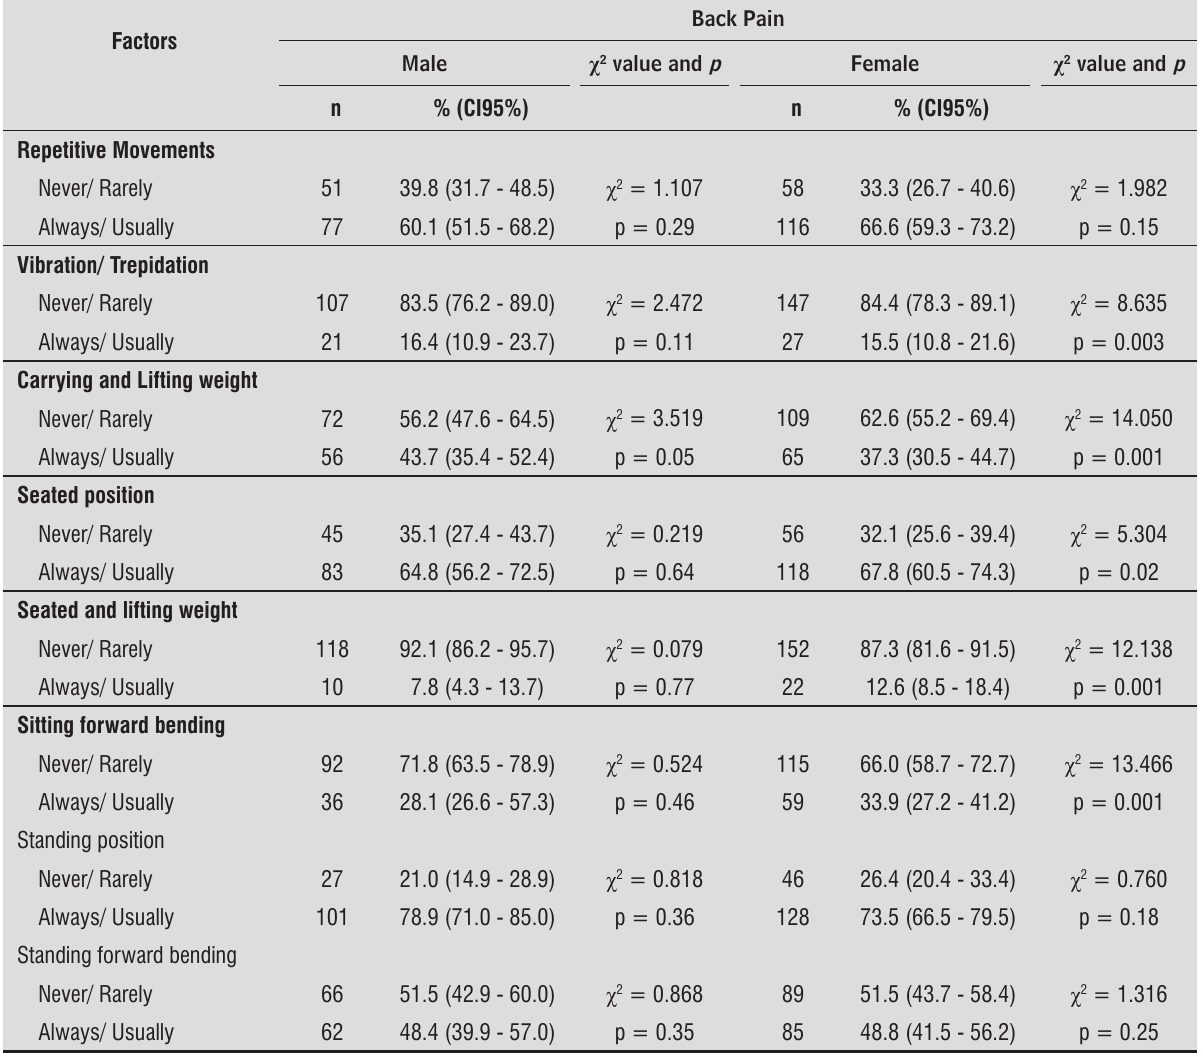
Table 4 - Bivariate analysis between back pain and ergonomic variables of the sample with subjects over 20 years old, liv- ing in the city of Bauru (São Paulo, Brazil), by